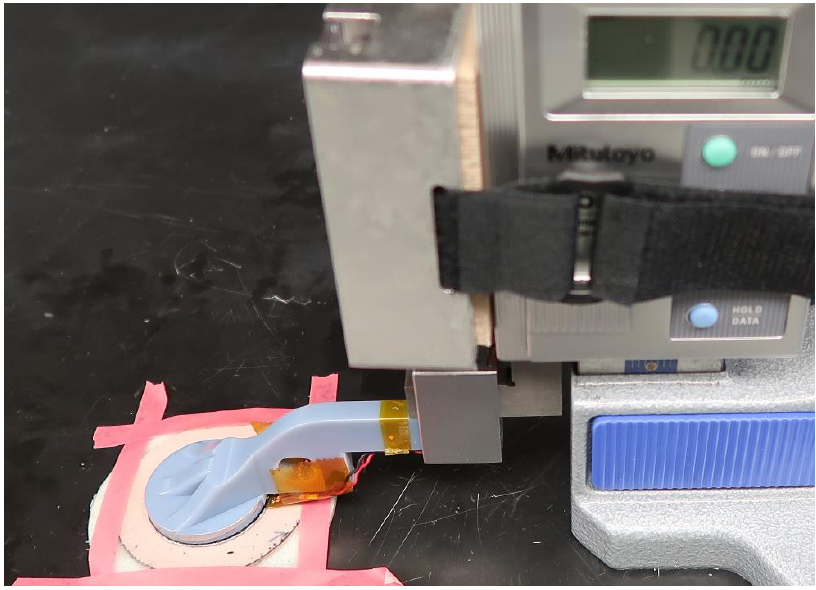
Figure 5. Calibration unit.